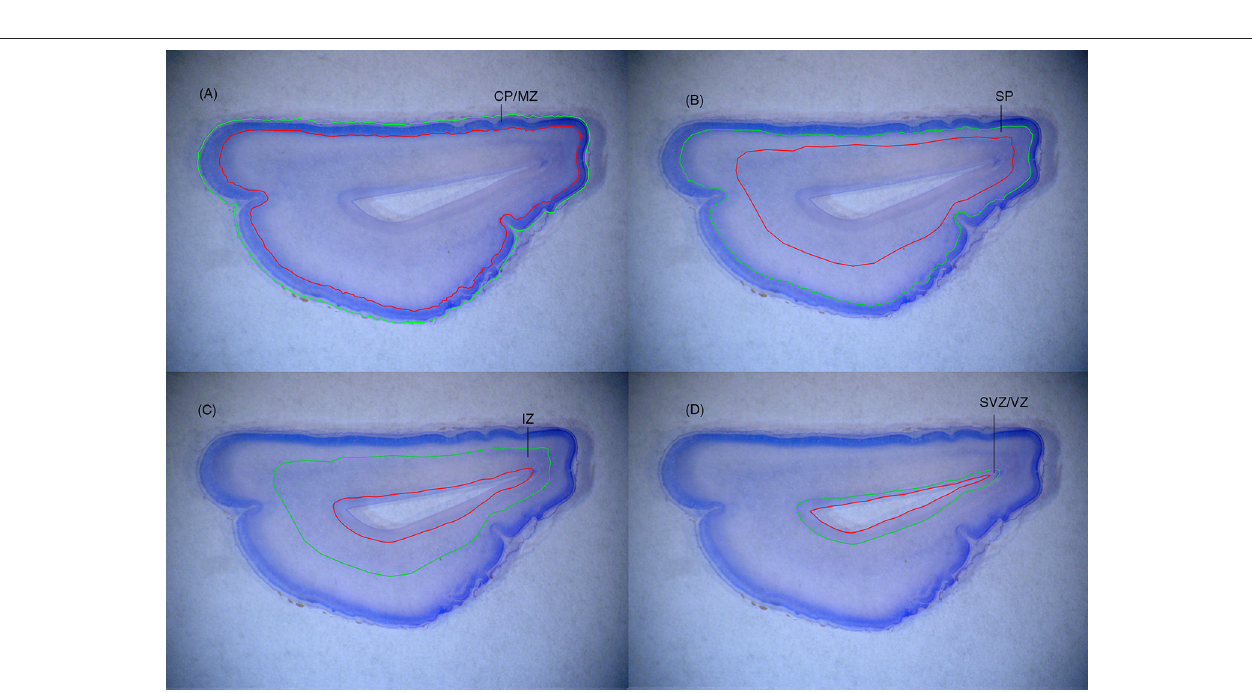
FIGURE 1 | (A) A known fraction, the section sampling fraction, ssf , is chosen. In this case five sections (lines are representing sections) are chosen from the object of interest, and (B) a step length (x, y) and a counting frame area a(frame) are applied. After placement of a 2D unbiased counting frame, a(frame) in the first = = predetermined x,y interval, the remainder of the positions of the counting frame in the x,y intervals are repositioned using a stepping motor. (C) Each black square is an optical disector with a fixed height, h . Modified from Figure 5.19 in Howard and Reed (2010).